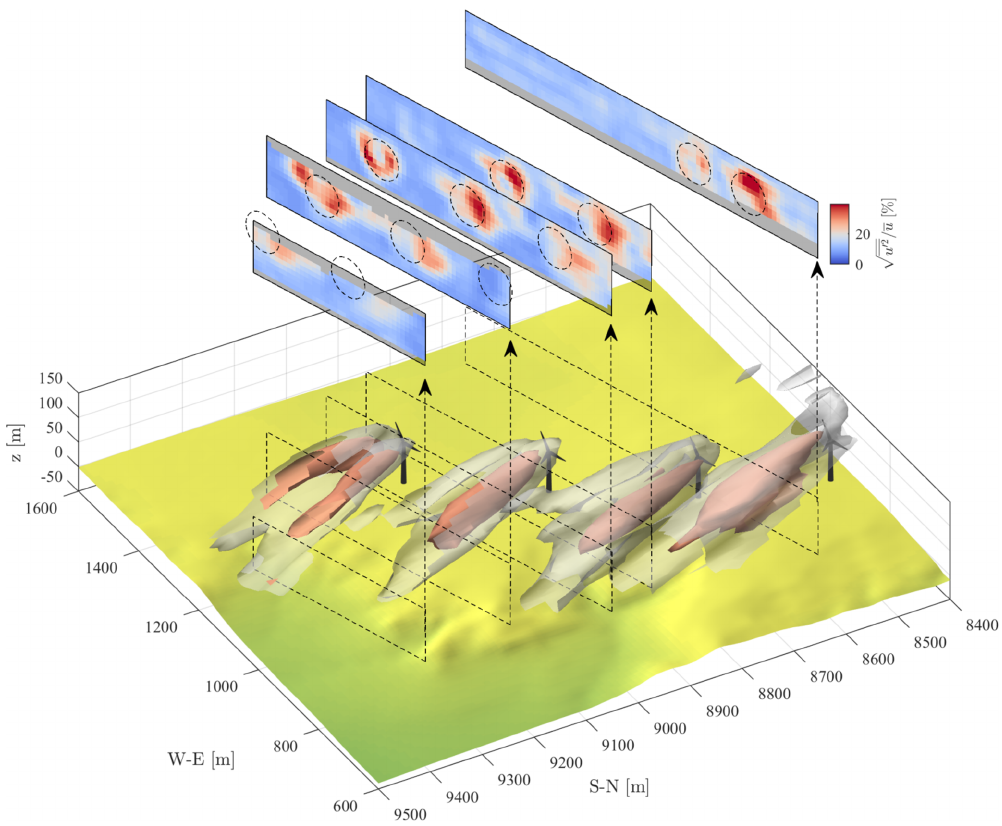
(cid:113) u (cid:48) 2 /u levels of 20%